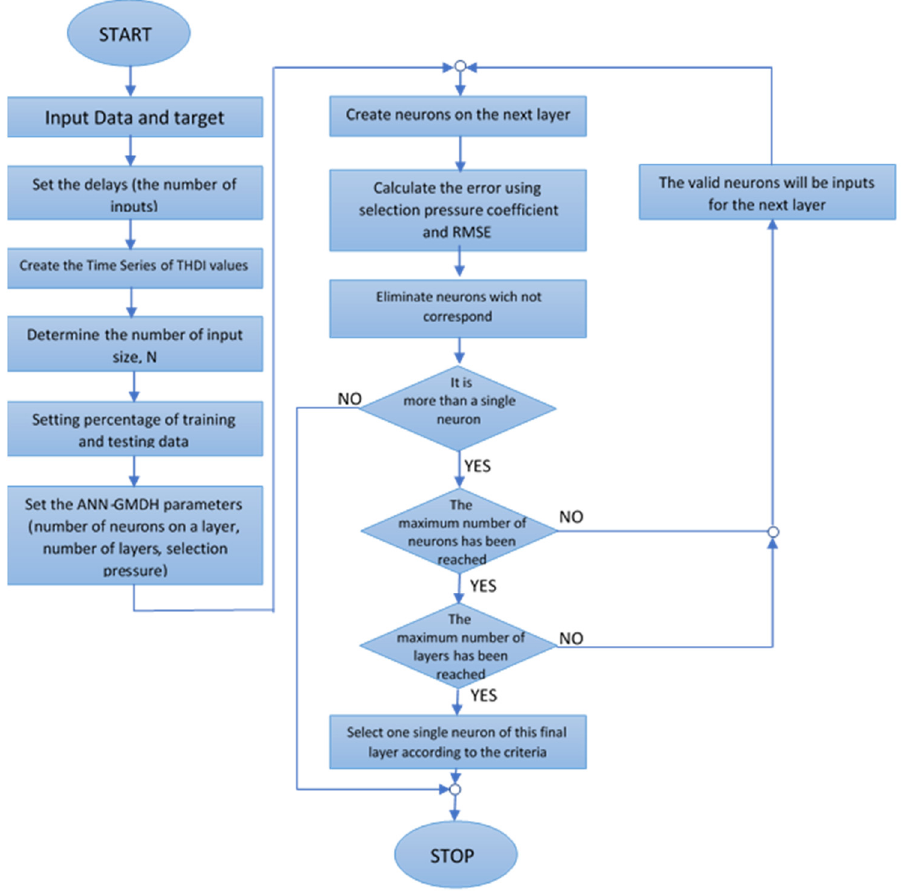
Figure 9. Flowchart of the GMDH algorithm.